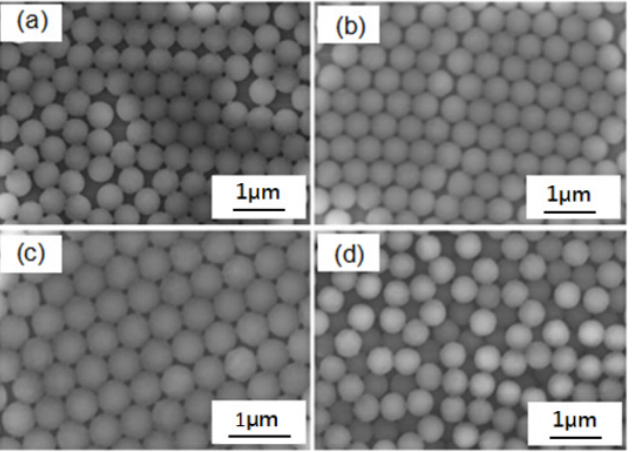
Figure 7. SEM images of self-assembly PS nanosphere masks fabricated as a function of the concentration of PS nanospheres in the dipping solution. ( a ) 4 wt %; ( b ) 6 wt %; ( c ) 8 wt %; and ( d ) 10 wt %, respectively.